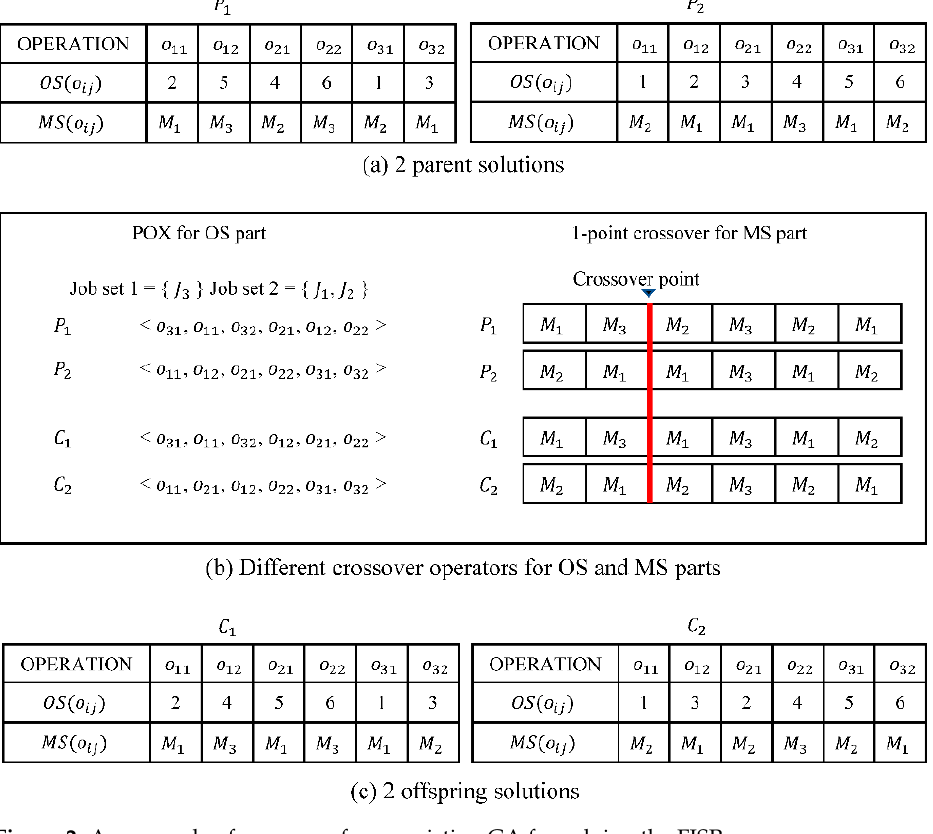
Figure 2. An example of crossover for an existing GA for solving the FJSP.